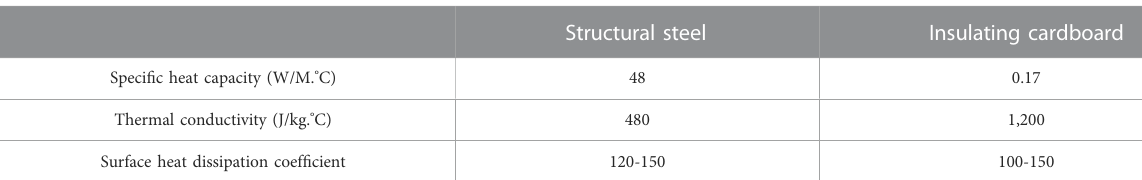
TABLE 1 Magneto-thermal coupling fi eld parameter setting.